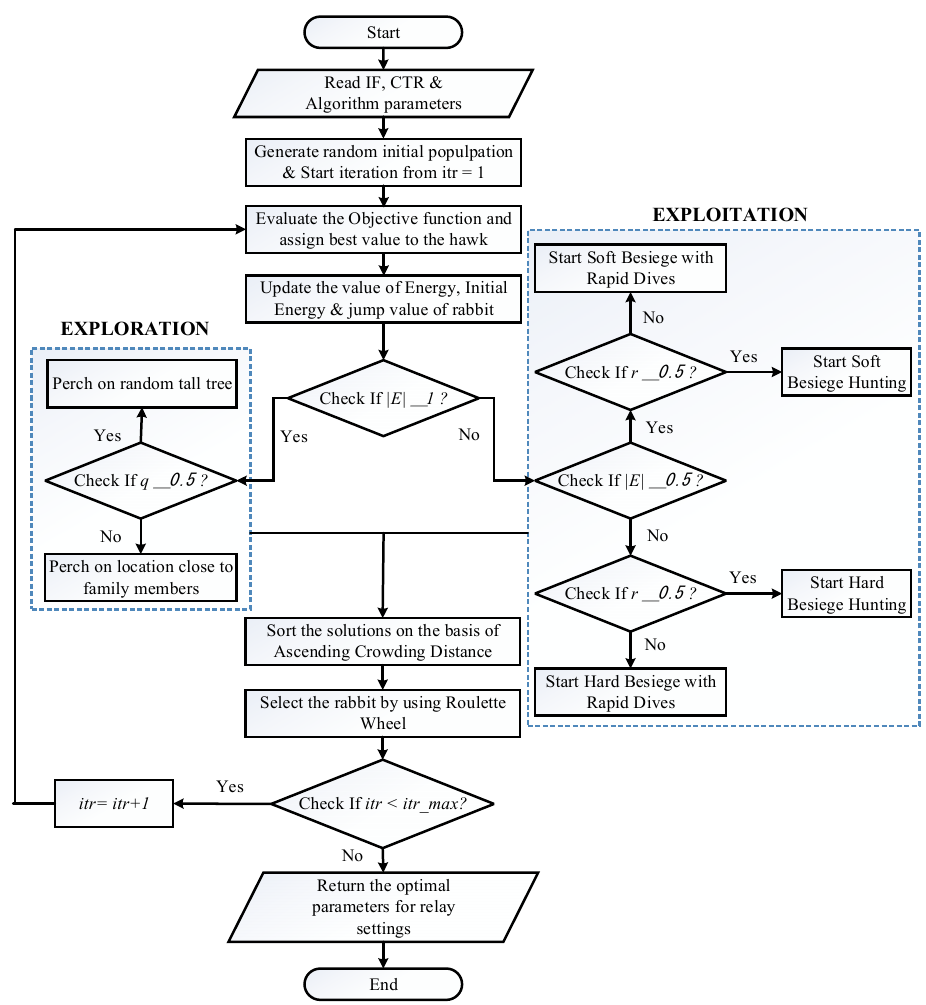
Figure 3. Flowchart for modified Harris hawk optimization (MHHO).